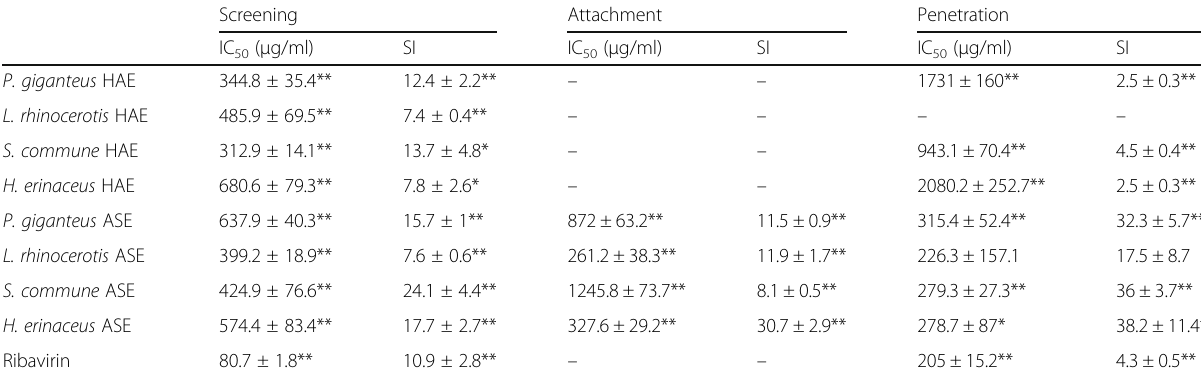
Table 4 Inhibitory activities of the mushroom HAEs and ASEs during screening, attachment and penetration assays